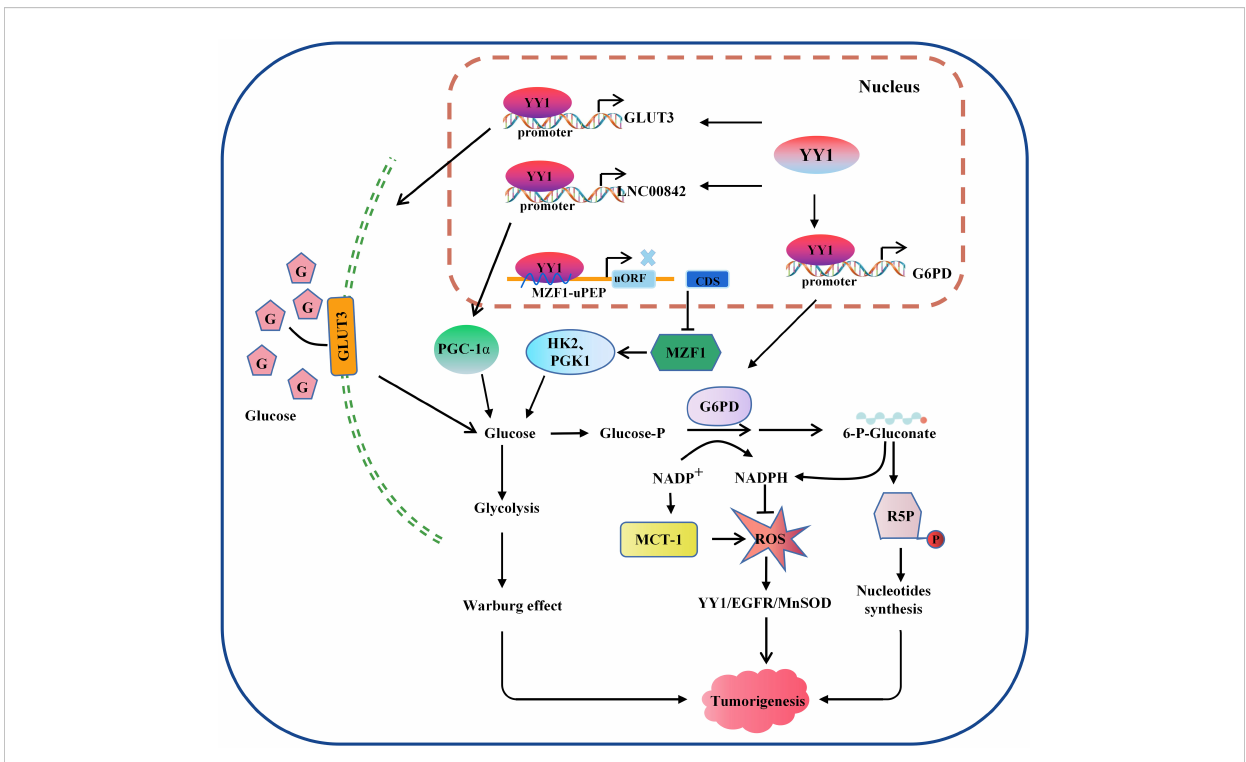
FIGURE 3 Model of the mechanism through which YY1 regulates glucose metabolism. YY1 is involved in regulating glucose metabolism in tumor cells by affecting the transcription activation of some key molecules. For example, activation of GLUT3 and LNC00842 transcription enhances aerobic glycolysis in tumor cells, while downregulation of YY1 by MZF1 inhibits the transcription of its downstream glycolytic genes HK2 and PGK1, thereby inhibiting aerobic glycolysis. In addition, YY1 activates G6PD transcription and stimulates the pentose phosphate pathway to enhance nucleotide generation and DNA synthesis and reduce intracellular reactive oxygen species levels, thus promoting tumorigenesis. YY1, Yin Yang 1; G6PD, glucose-6-phosphate dehydrogenase; GLUT, glucose transporter; ROS, reactive oxygen species; HK2, hexokinase 2; PGK1, phosphoglycerate